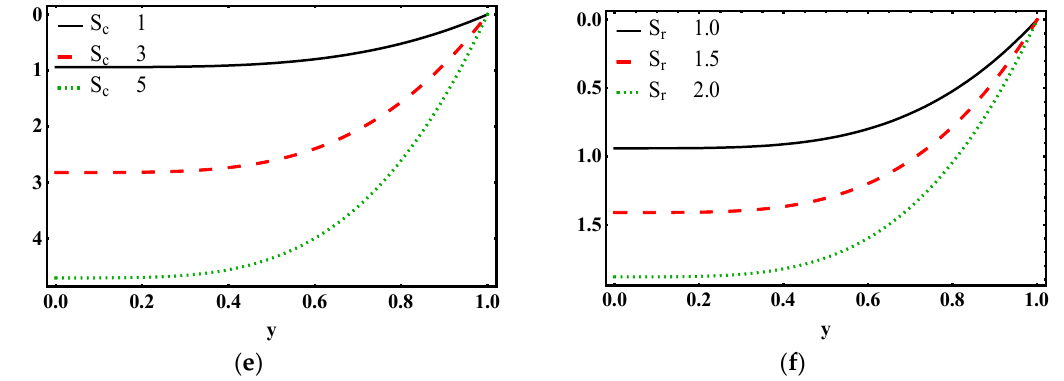
Figure 10. Concentration profile for ( a ) . Г ( b ) . m e ( c ) . U hs ( d ) . B r . ( e ) . S c ( f ) . S r , while other parameters are Г = 0.01, x = π , ε = 0.2, Θ = 1, m e = 2, U hs = − 1, B r = 1, S c = 1, S r = 1.